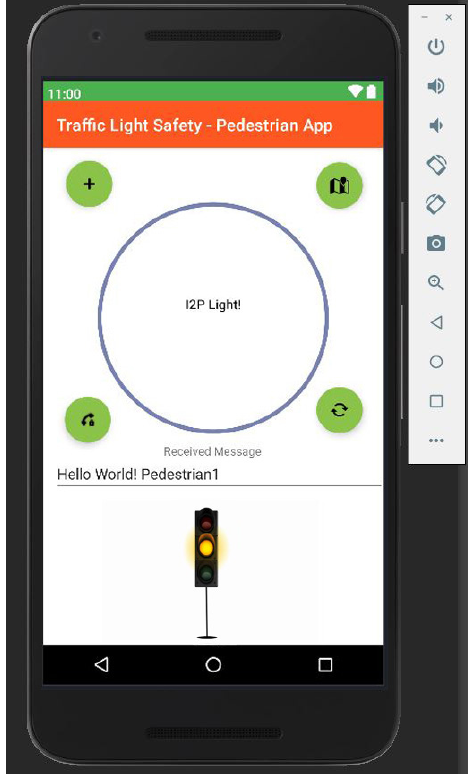
Figure 15. Android Studio interface dedicated to the color analysis of traffic lights and direct com- munication with other users. Pedestrian and road safety and prevention events.